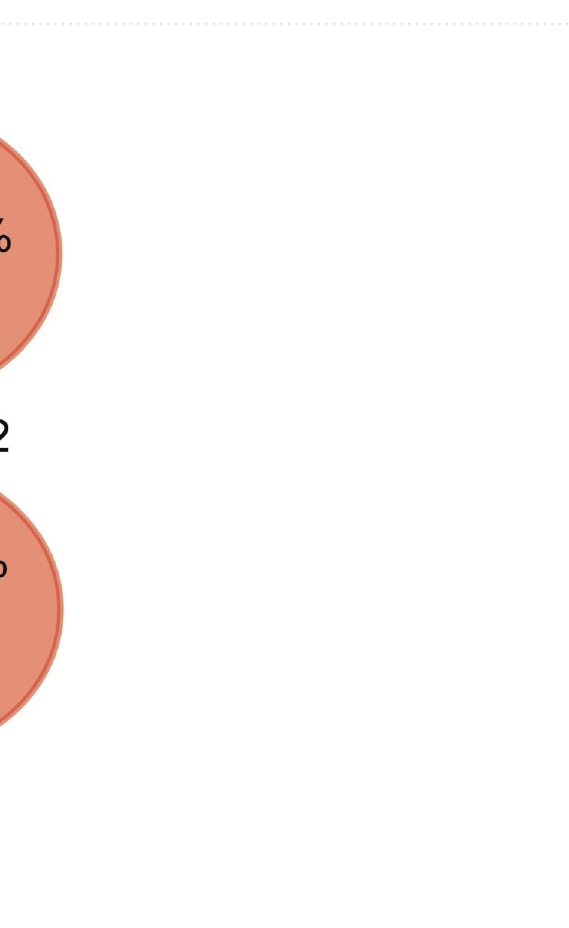
Table 1. Effect of different seasons (autumn and winter) and three climatic zones on airborne fungal richness, Shannon diversity index, evenness and abundance of the 10 most common operational taxonomic OTUs (OTUs) in industrial grain mills. Statistically significant differences among studies factor variables were analyzed using ANOVA and Tukey’s HSD post-hoc test. Bold values represent differences significant at a P -value < 0.05.